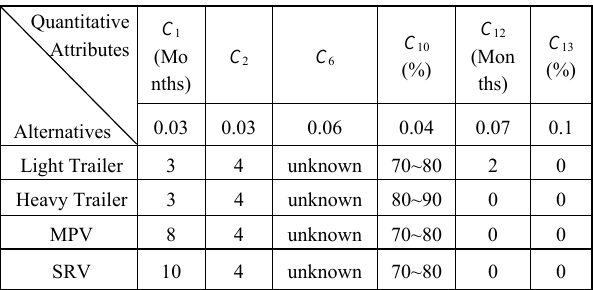
Table 2. Original evaluation of strategic R&D projects in quantitative